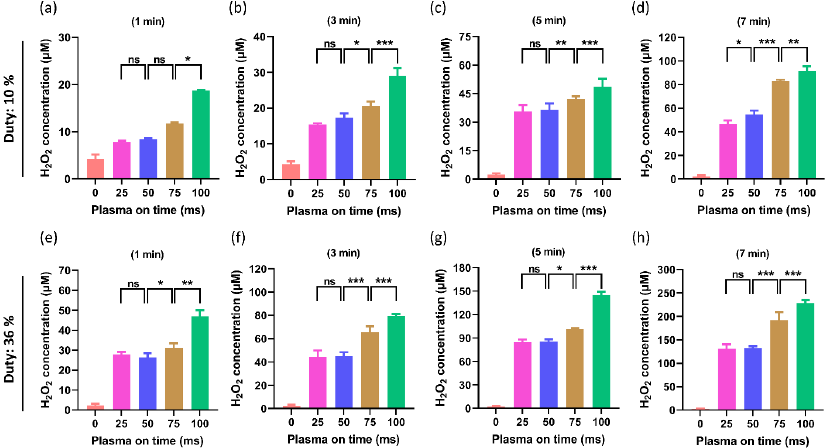
Figure 8. The H 2 O 2 content in PTM. Only plasma on ‐ time was altered as 25, 50, 75, and 100 ms in each treatment time and duty ratio. ( a – d ) The H 2 O 2 content in PTM when the duty ratio was fixed at 10%. ( e – h ) The H 2 O 2 when the duty ratio is maintained at 36%. It was found that the H 2 O 2 levels significantly increased gradually by increasing the plasma on ‐ time. The 25 ms and 50 ms plasma on ‐ time showed similar H 2 O 2 levels. The significance was calculated using Microsoft Excel (MS Office 365), while the differences between the treatment groups are indicated by * p < 0.05, ** p < 0.01, *** p < 0.001, ns—not significant.